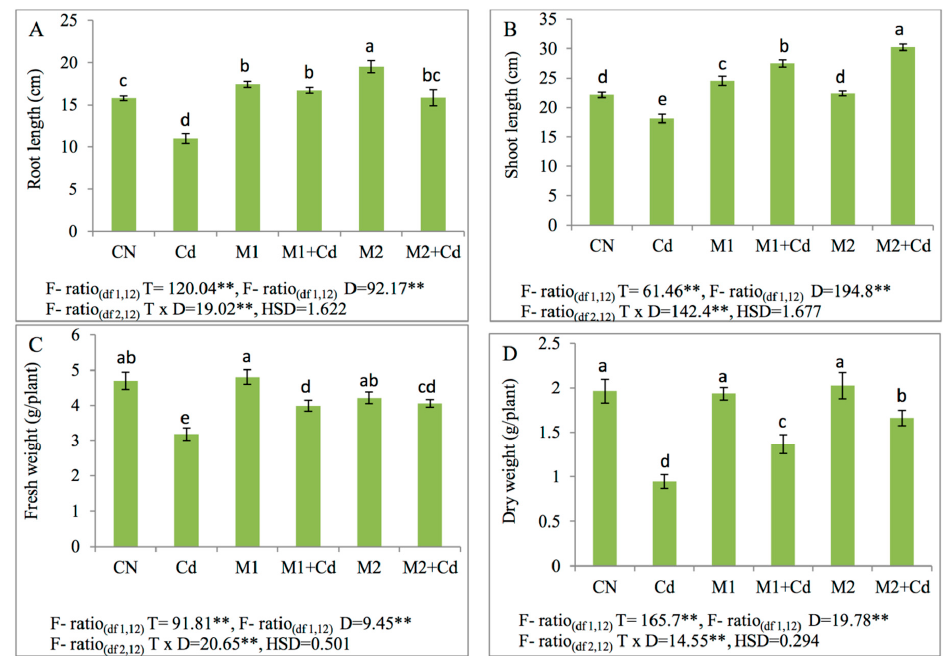
Figure 1. E ff ect of M1 (10 9 cells / mL) and M2 (10 9 cells / mL) and on: ( A ) Root length, ( B ) shoot length, ( C ) fresh weight, and ( D ) dry weight in 45-day-old L. esculentum under Cd metal stress. Data is presented as means of 3 replicates ± S.D (standard deviation) and HSD values. F ratio values, * indicates significance at p ≤ 0.05 and ** indicates significance at p ≤ 0.01). Di ff erent letters on the table indicate that mean values of treatments are significantly di ff erent at p < 0.5 according to Tukey’s multiple comparison (CN—control, Cd—cadmium, M1— P. aeruginosa , M2— B. gladioli , T—treatment, D—dose, H.S.D—honestly significant di ff